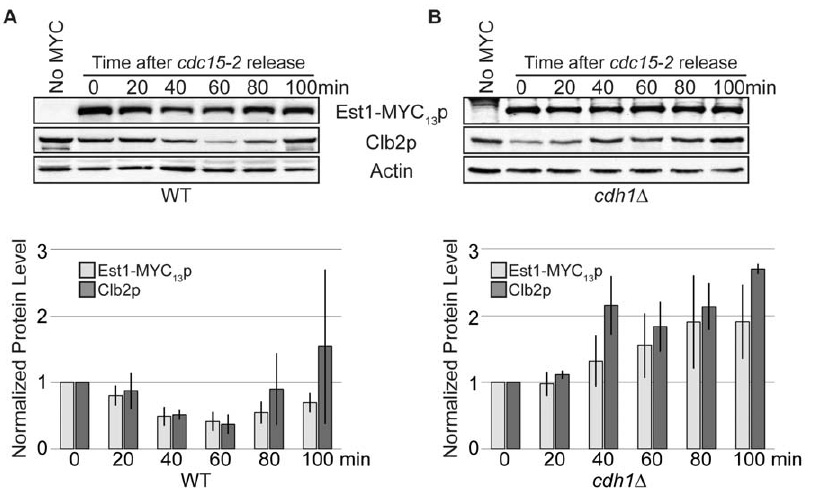
Figure 3. Cell-cycle oscillation of Est1p requires Cdh1p. (A) Est1 protein levels oscillate through the cell cycle. Strain YKF808 ( cdc15-2 EST1- MYC 13 ) was grown asynchronously at 23 u C to mid-log phase and shifted to the restrictive temperature (37 u C) for 3.5 hrs. When 95% of the cells were arrested, as monitored by bud-index (Figure S2), the culture was returned to the permissive temperature (23 u C; time 0). Whole-cell extract was prepared from samples harvested every 20 mins following release and western blotted using anti-MYC, anti-Clb2p, and anti-Actin antibodies, as indicated. YCM191 ( cdc15-2 ) served as the untagged (No MYC) control for Est1-MYC 13 p and was harvested following the 37 u C incubation period. Est1- MYC 13 p and Clb2p intensity at each time were normalized to input (actin) and starting amount (time 0). Bars represent the average of four independent biological replicates for Est1-MYC 13 p (light) and Clb2p (dark); error bars are standard deviation of the mean. (B) Deletion of CDH1 perturbs the oscillation of Est1-MYC 13 p through the cell cycle. Strain YKF809 ( cdc15-2 cdh1 D EST1-MYC 13 ) was treated as in (A), except the bars represent the average of three independent biological